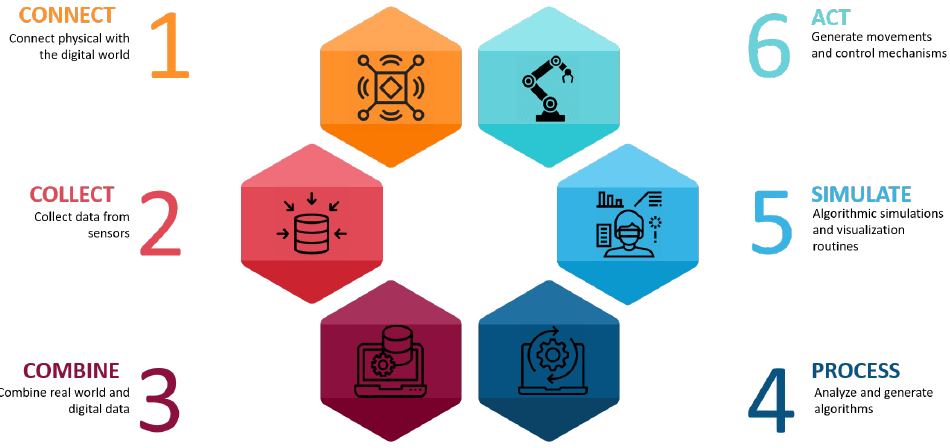
Figure 1. The conceptual digital twin